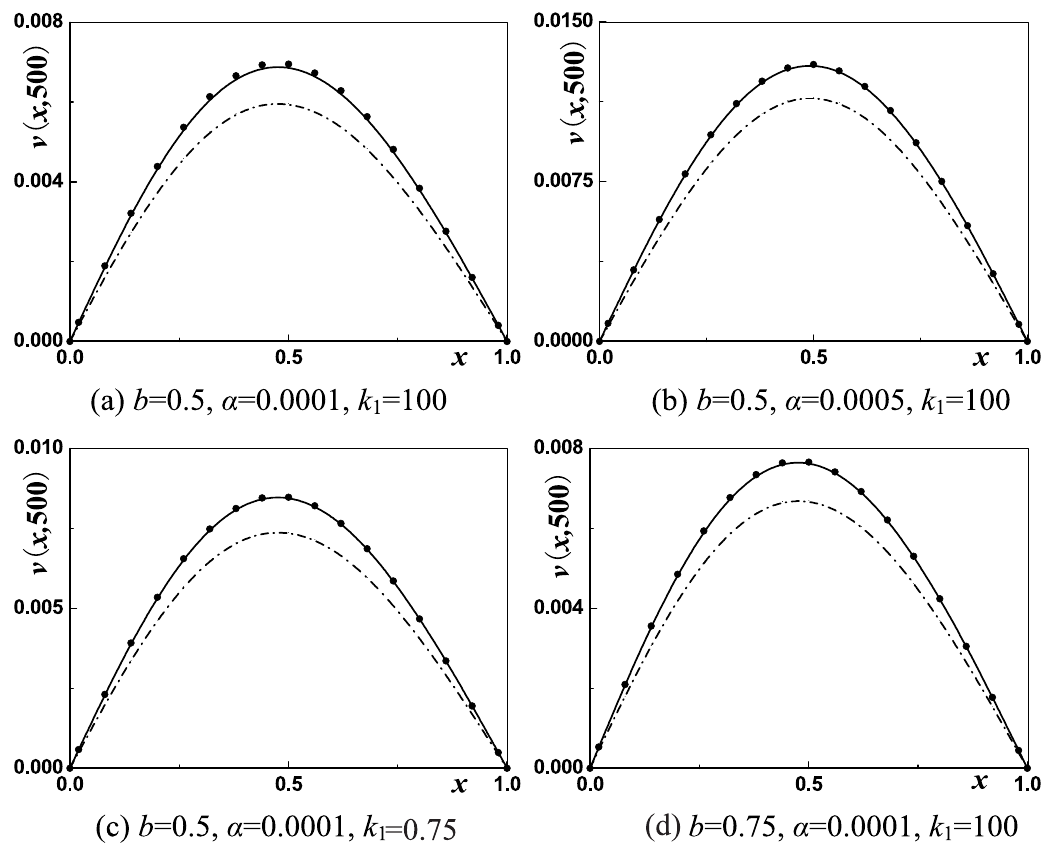
Fig. 3. The shape of beam calculated from three models in the first